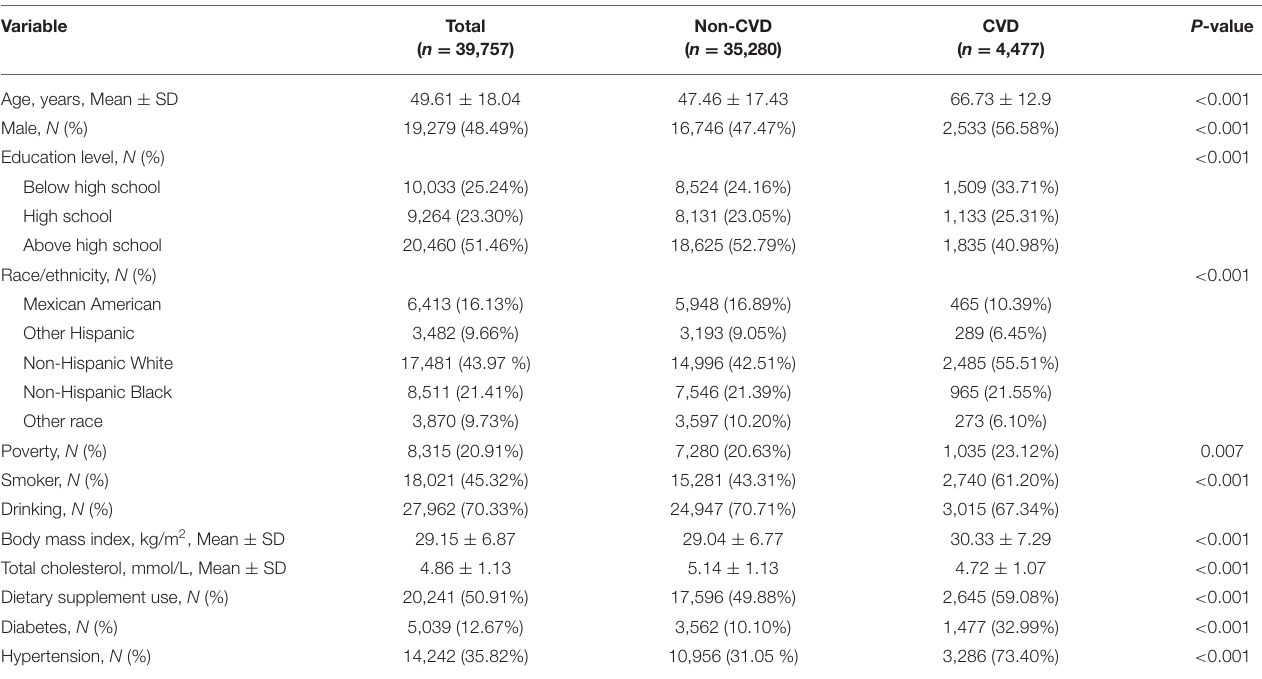
TABLE 1 | Sociodemographic characteristics of the study